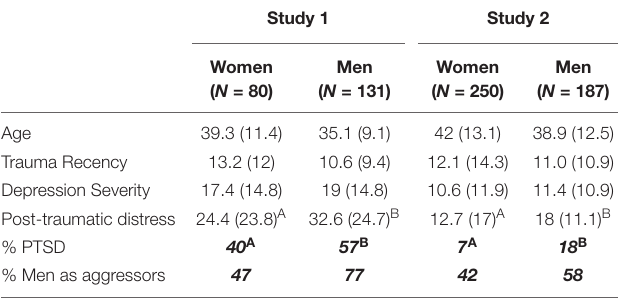
TABLE 1 | Age, depression, and event related factors among men and